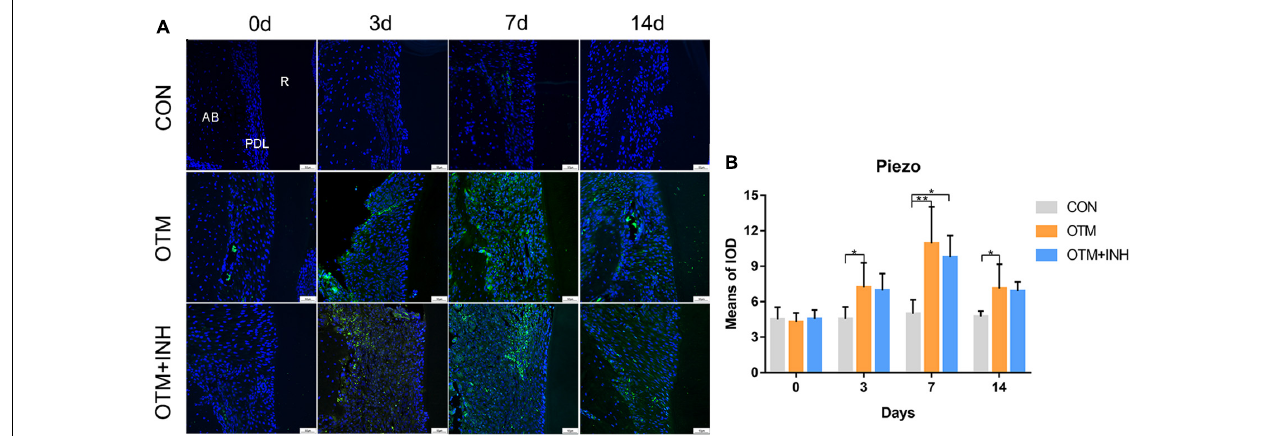
FIGURE 1 | The expression of Piezo1 was activated by orthodontic force on the tension side of distobuccal roots. (A) Immunofluorescence staining showed that Piezo1 was mainly expressed in the PDL of the OTM and OTM + INH groups after orthodontic force application. (B) The means of the fluorescent intensity of Piezo1. The expression of Piezo1 in the OTM group was significantly greater than that in the CON group from day 3 to day 14. Data are presented as the mean ± SD. * p < 0.05. ** p < 0.01. Scale bar = 50 µ m. INH, inhibitor; OTM: orthodontic tooth movement; AB, alveolar bone; PDL, periodontal ligament; R, root.